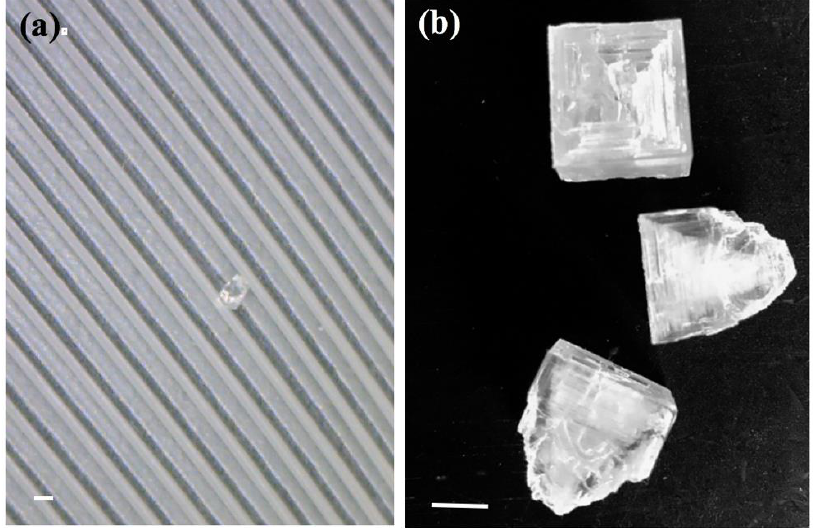
Figure 3. Halite crystals from Great Salt Lake. ( a ) A tiny halite crystal on a feather from an American White Pelican from the breeding colony on Gunnison Island, scale bar is 1mm. ( b ) Hopper halite crystals collected from Rozel Bay, scale bar is 1 cm.